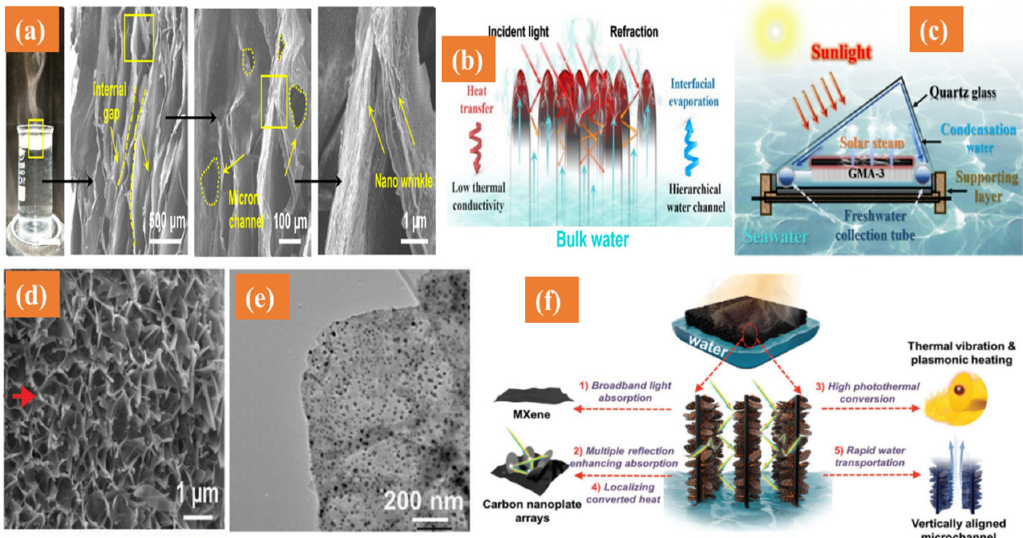
Figure 4. ( a ) Internal gap, microchannels, and nano wrinkles developed on the internal surface of GO supported Ti 3 C 2 MXene aerogels for water supplying channels during solar desalination, ( b ) internal light refraction for superior light absorption and heat localization for interfacial evaporation at low thermal conductivity, and ( c ) schematic representation of solar desalination process by the GMA-3 (reprinted from Ref. [53], copyright with permission from Elsevier, 2020), ( d ) magnified SEM image of 3D Ti 3 C 2 MXene nanosheets supported hierarchical cobalt nanoparticle–carbonaceous nanosheets/MXene foam, ( e ) corresponding TEM image with Co nanoparticles within the Co-CNS/M foam, and ( f ) key features which improved the solar desalination of Co-CNS/M foam. (Reprinted from Ref. [17], copyright with permission from Wiley Online Library,